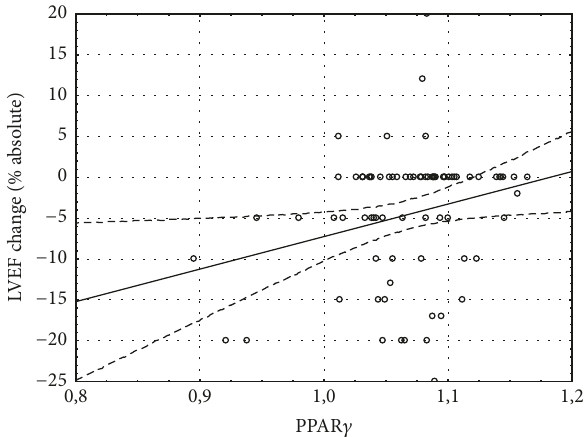
Figure 4: LVEF change between 1- and 12-month follow-up was significantlycorrelatedwithmyocardialPPAR 𝛾 inpatients,inwhom heart failure was diagnosed ( 𝑅 = 0.25 , 𝑝 < 0.05 ).